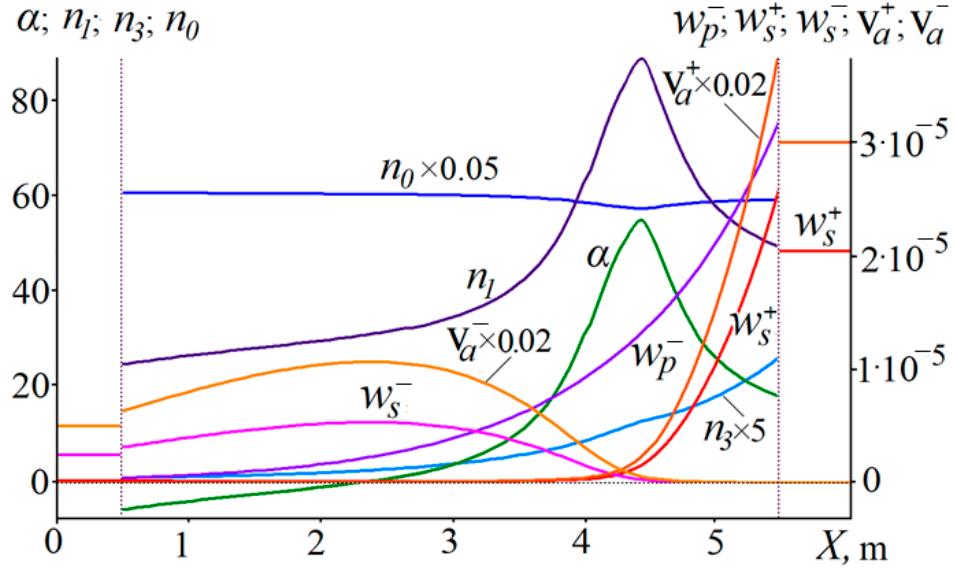
Figure 3. Distributions of active medium parameters in the stationary state. Left scale: level popu- lations n 0 , n 1 , n 3 and the gain coefficient α ; Right scale: the intensities of narrowband w + s , w − s and broadband v + a , v − a ASE waves, and the pump wave w − p intensity.